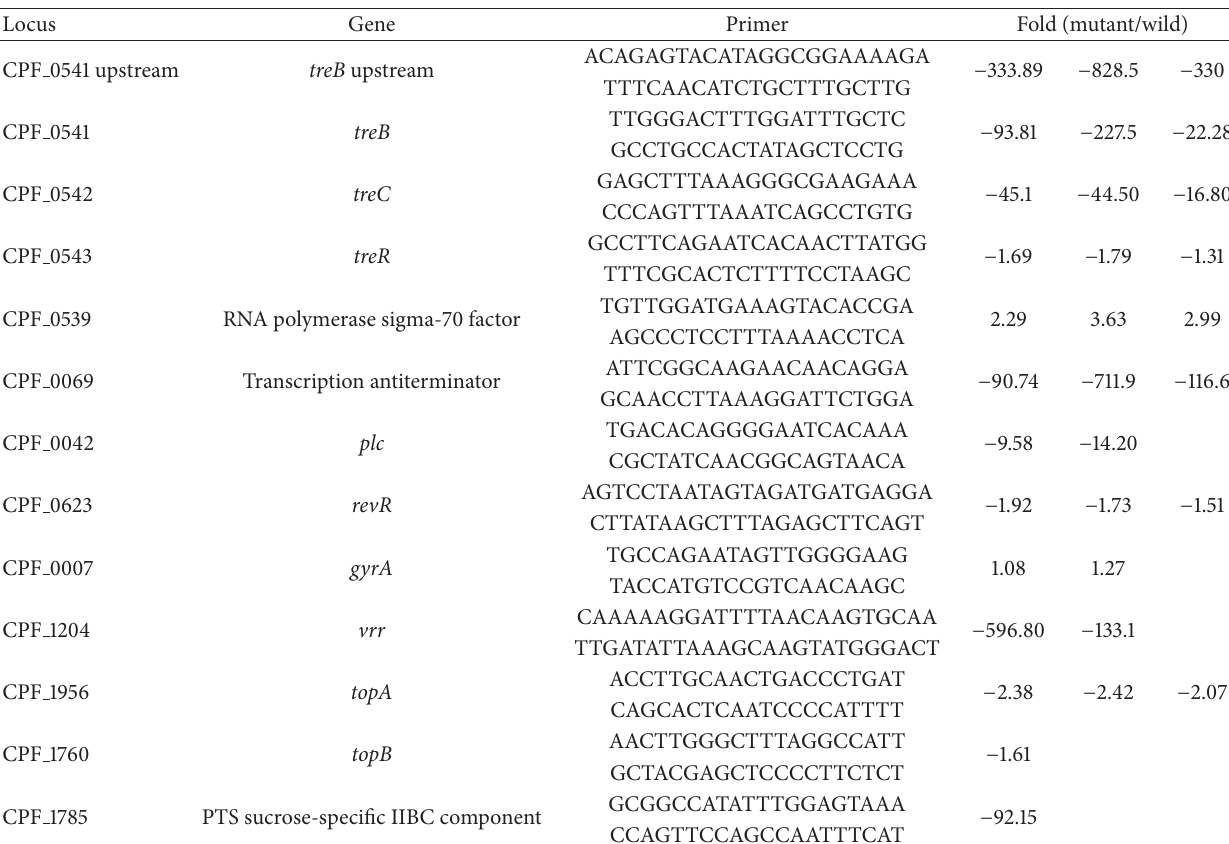
Table 2: Comparison of the gene transcription in wild type C. perfringens ATCC 13124 and gatifloxacin resistant mutant 13124 GR by qRT- PCR a